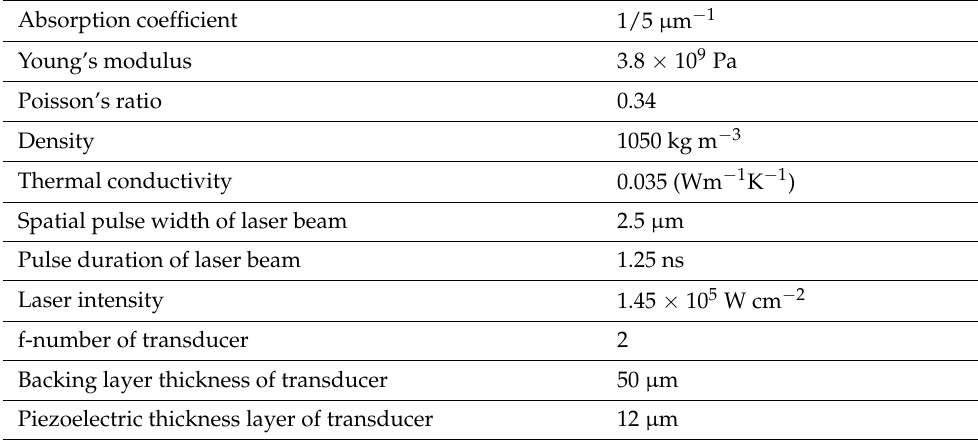
Table 1. Parameters for the microparticle, used in the COMSOL